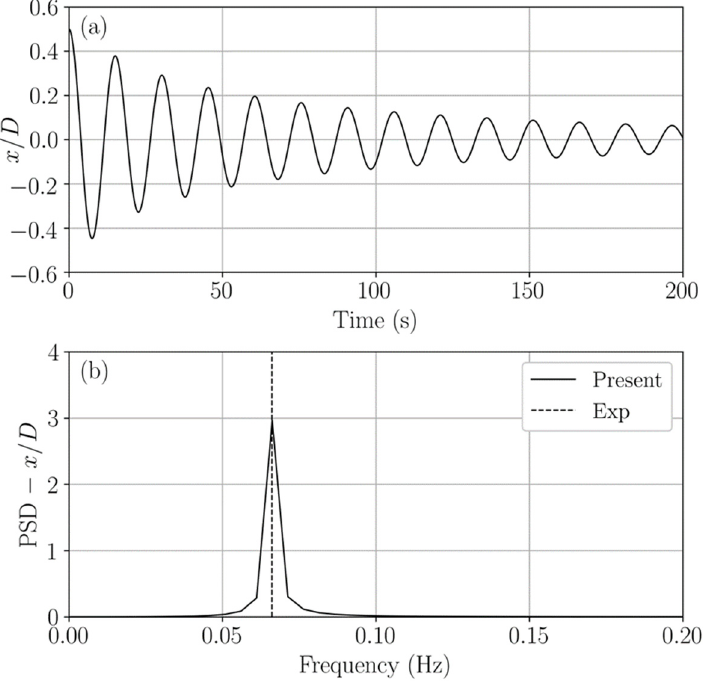
Figure 7. Free decay test of FOWT platform in inline direction: ( a ) time series; ( b ) PSD.